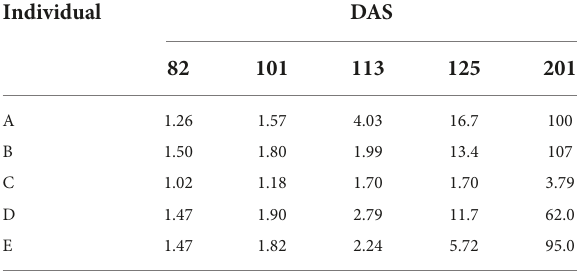
TABLE 1 Length of the microcotyledon.